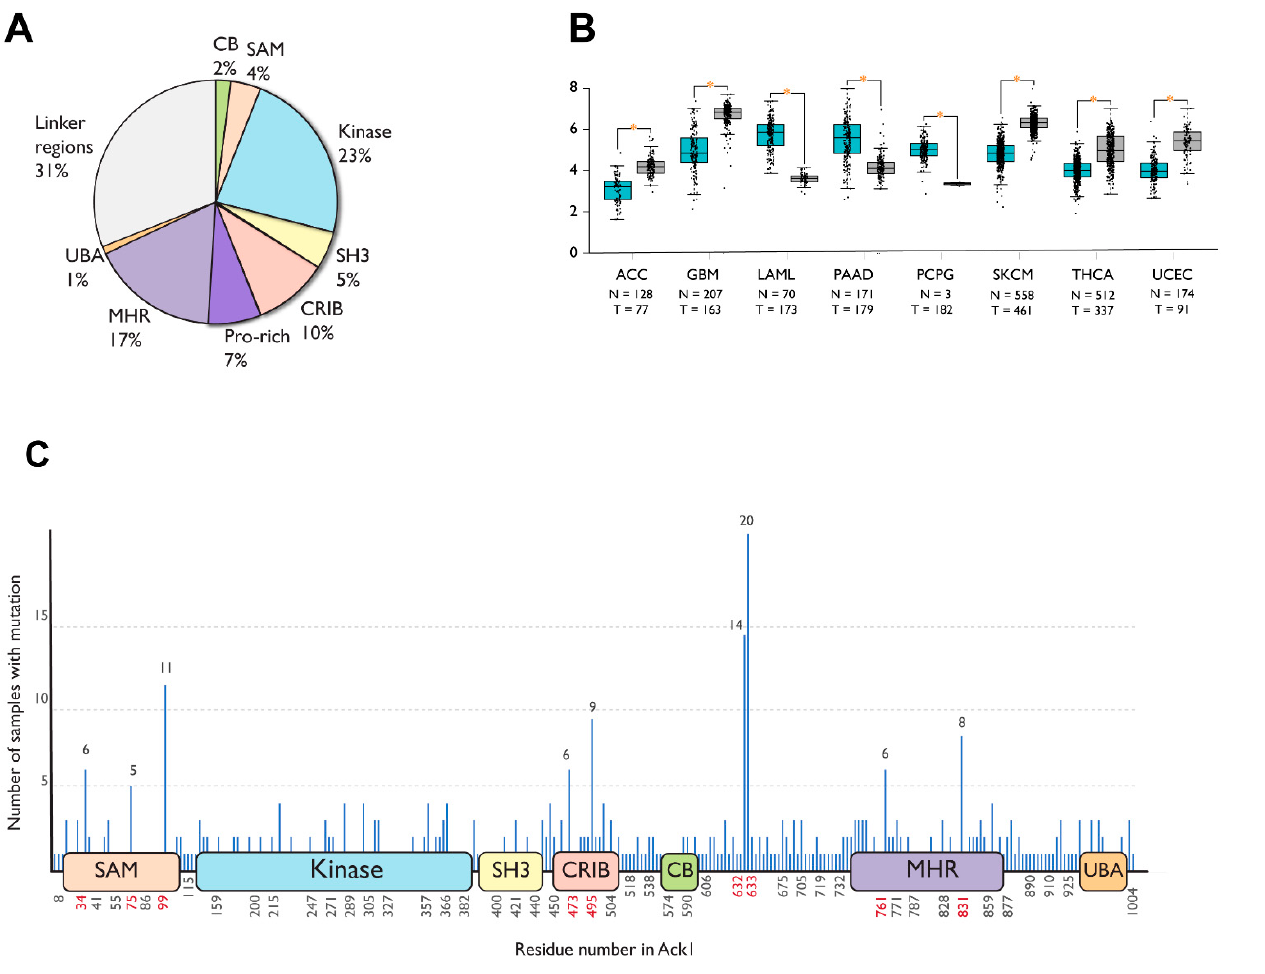
Figure 5. Cancer-associated mutations in Ack1 in the COSMIC database. ( A ) Distribution of nonsynonymous mutations. SAM, sterile alpha motif; CRIB, Cdc42, and Rac-interactive binding (CRIB) domain; CB, clathrin-binding motif; proline-rich region; MHR, Mig6 homology region; UBA, ubiq- uitin-associated domain ( B ) Ack1 expression in normal (blue) vs. tumor (gray) tissues. ACC: adre- nocortical carcinoma, GBM: glioblastoma multiforme, LAML: acute myeloid leukemia, PAAD: pan- creatic adenocarcinoma, PCPG: pheochromocytoma, SKCM: skin cutaneous melanoma, THCA: thy- roid carcinoma, UCEC: uterine corpus endometrial carcinoma. ( C ) Locations of cancer-associated mutations outlined in the linear structure of Ack1. SAM, sterile alpha motif; NES, nuclear export signal; CRIB, Cdc42, and Rac-interactive binding (CRIB) domain; clathrin-binding motif; proline- rich region; MHR, Mig6 homology region; UBA, ubiquitin-associated domain. Each horizontal line represents a mutation, with the number of mutations positively correlated with the length depicted on the y- axis. The x -axis shows the location of the mutations. Highly mutated residues are shown in red. Note that the numbering convention used in COSMIC is based on an isoform different from the